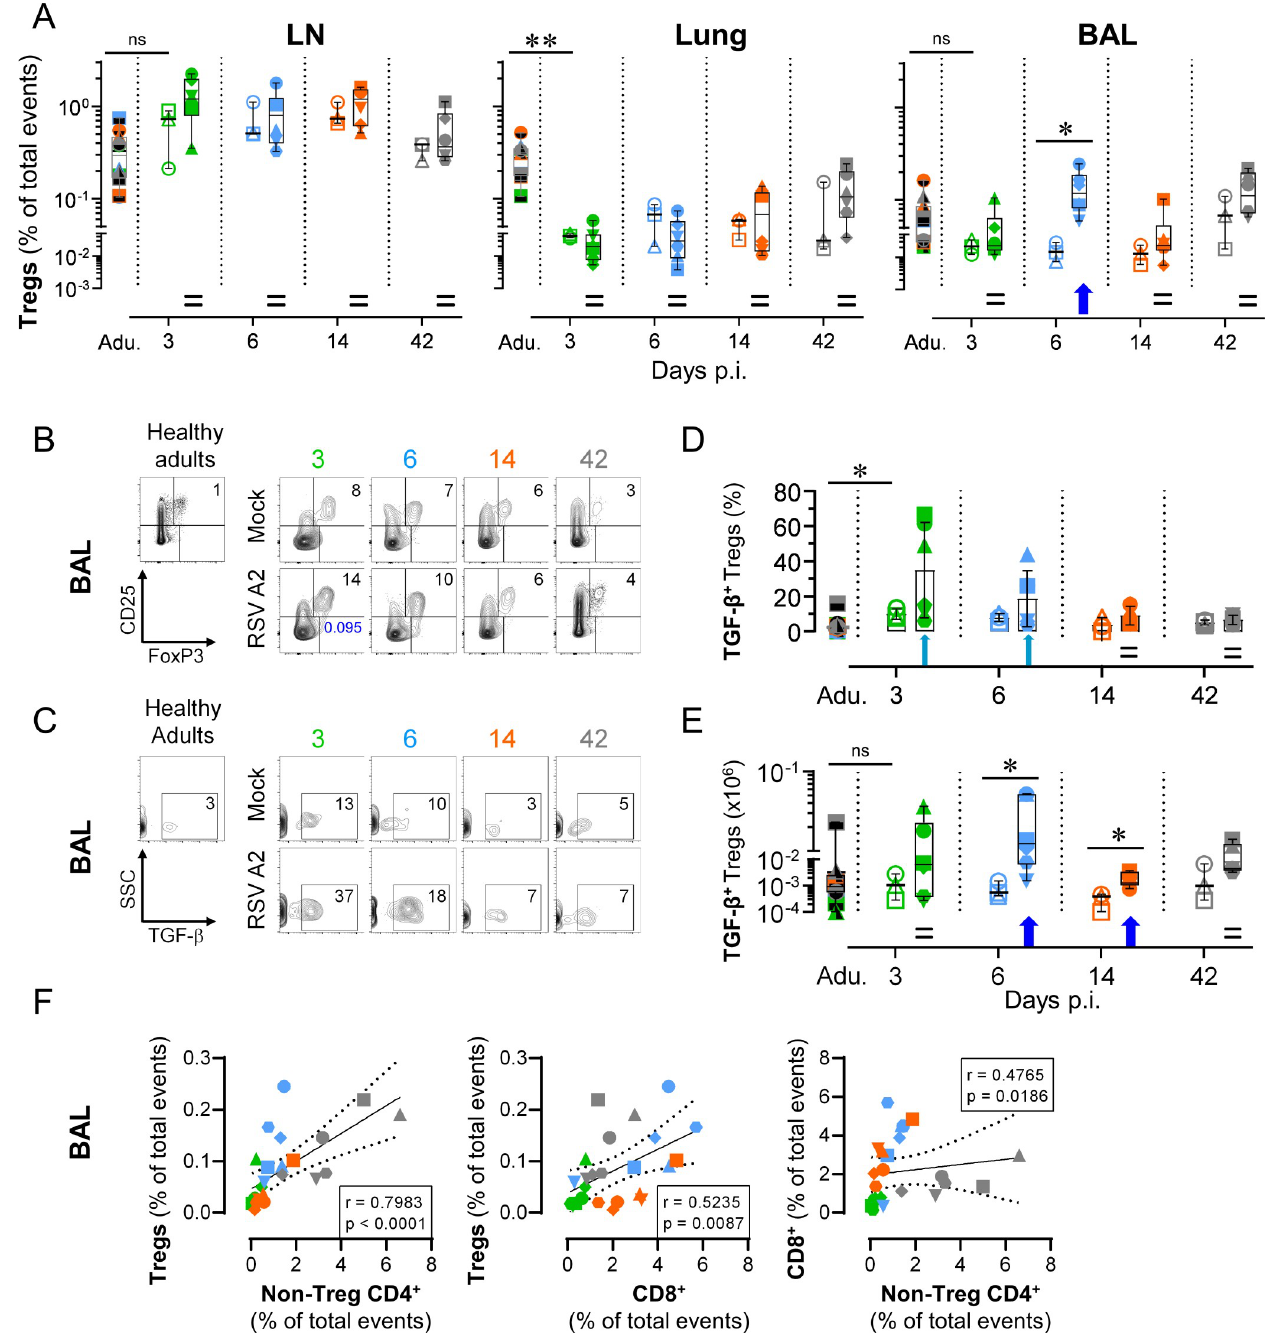
Fig 5. Neonatal RSV A2 infection rapidly induces Treg suppressive functions to dampen the Th2 and Tc2 responses. (A) RSV A2 infection in neonates led to the recruitment of Tregs in the bronchoalveolar space, but not in peribronchial LNs or lung tissue. (B) Progressive decrease with age of Treg subset among the CD4 + T cell fraction (representative FCM contour plots). Numbers indicate the mean percentage of animals per group per time point. Number in blue indicate a trends to increase at day 3 p.i. (C) Representative contour plots with the frequency of TGF- β -producing Tregs. Numbers indicate the mean percentage of animals per group per time point. (D) As in (C), but with plot displaying all individuals. (E) Absolute count of recruited TGF- β + Tregs in bronchoalveolar space upon RSV A2 infection. (F) Correlation coefficient (r) obtained in BALs with Treg counts calculated as a function of non-Treg CD4 + counts (left), Treg counts calculated as a function of CD8 + counts (middle) and CD8 + counts calculated as a function of non-Treg CD4 + counts (right). Significance was reached for the three correlations. (A-F) Each symbol represents an individual animal (healthy adults, n = 12; mock neonates, n = 3 per time point; neonates infected with RSV, n = 6 per time point). Boxplots indicate median value (center line) and interquartile ranges (box edges), with whiskers extending to the lowest and the highest values. Adu., healthy adults. Groups were compared using Mann–Whitney U test (A-E). Stars indicate significance levels. � , p < 0.05; �� , p <